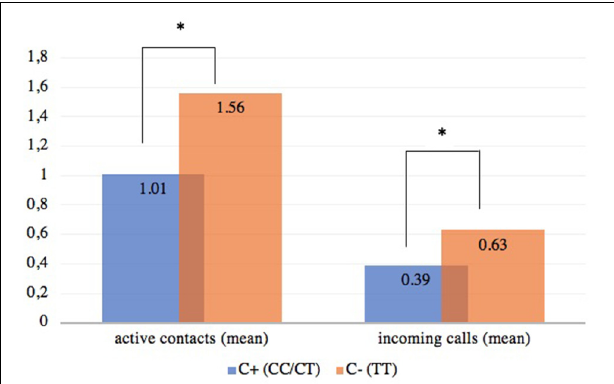
FIGURE 1 | Association between the rs2268498 genotypes and the smartphone variables active contacts and incoming calls. N (C+) = 88, n (C–) = 29, ∗ p < 0.05. Please note that the depicted significance is derived by the means of the Mann-Whitney U test. The means of the variables on the Y axis (and not the mean ranks) are presented here for reasons of